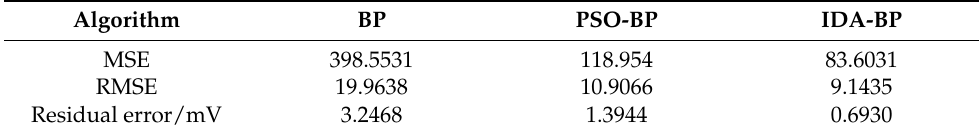
Table 1. Comparison of the three models.